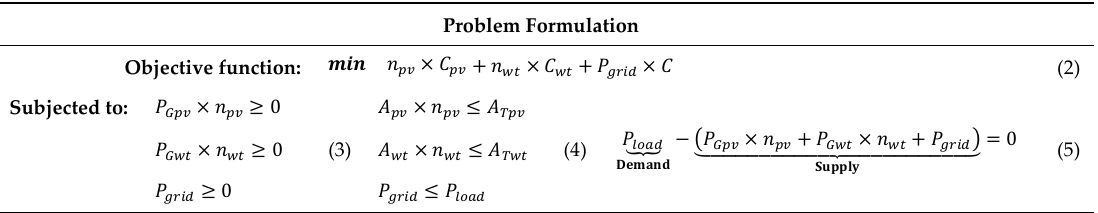
Table A1. Case study formulation and results for achieving zero energy in all-electric